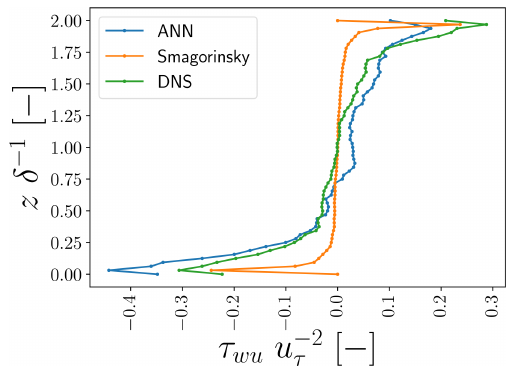
Figure 11. Vertical profiles of horizontally averaged (cid:15) SGS , DNS , (cid:15) SGS , ANN , and (cid:15) SGS , smag at one representative time step not used to train and validate the ANNs. All values are normalized by the friction velocity u − 3 τ and half-channel width δ